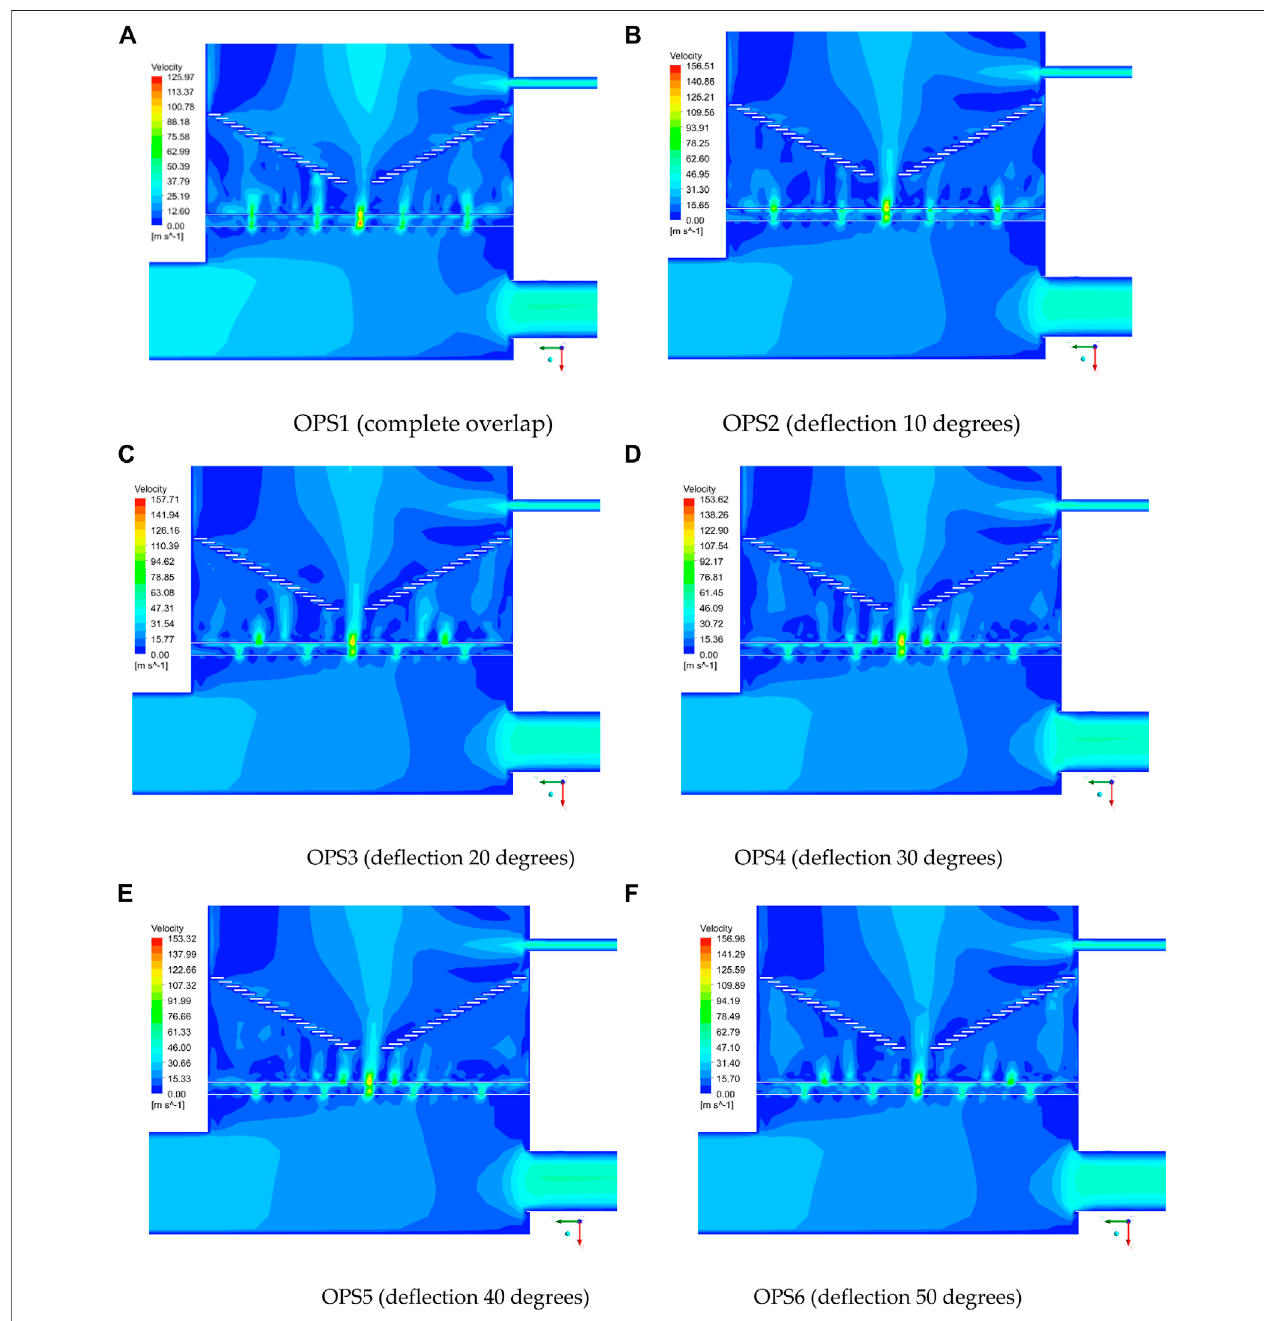
FIGURE 7 | In fl uence of OPS on the mainstream fi